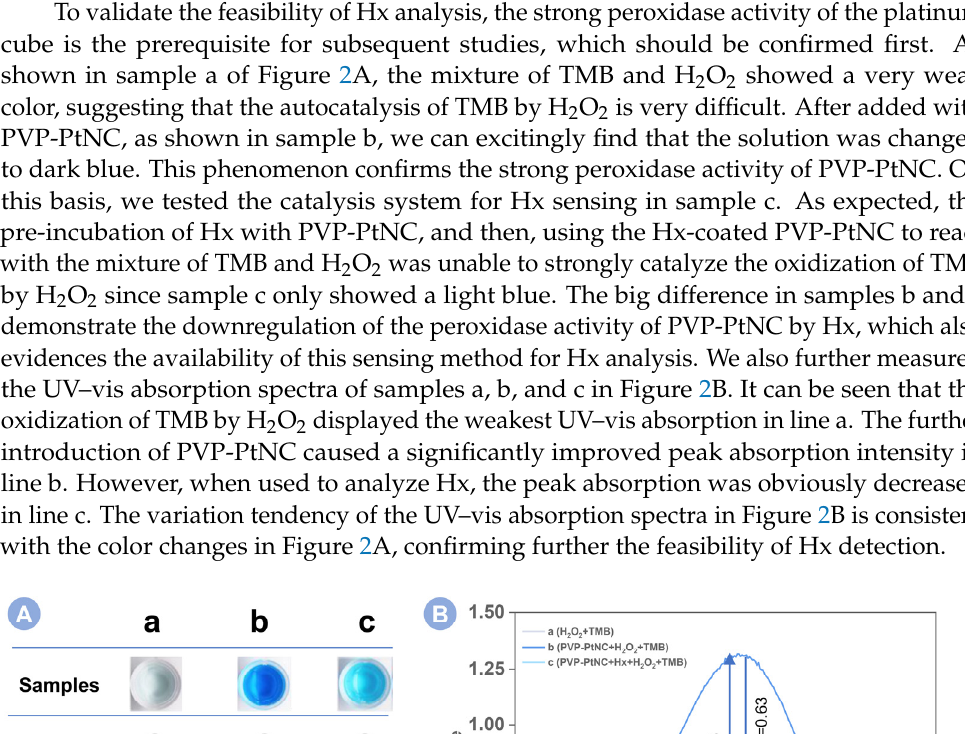
Figure 1. Schematic diagram of the working principle for the PVP-PtNC-based colorimetric detec- tion of Hx.